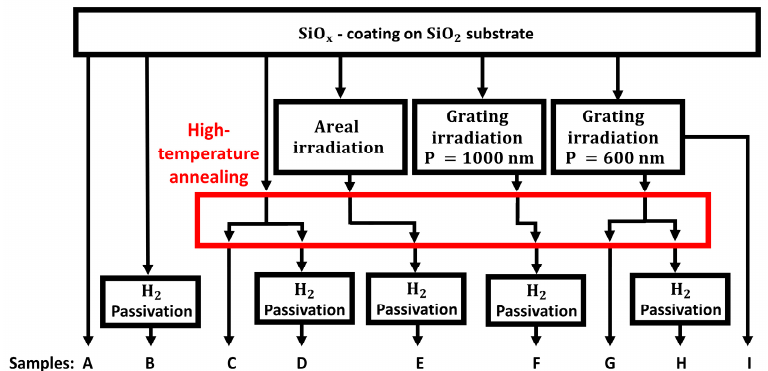
Figure 2. Process diagram for the production of the samples. All samples are SiO x coated on a SiO 2 substrate and subsequently experience either no or di ff erent laser irradiation and thermal treatment processes. The le tt er on the bo tt om denotes the designation of the individual